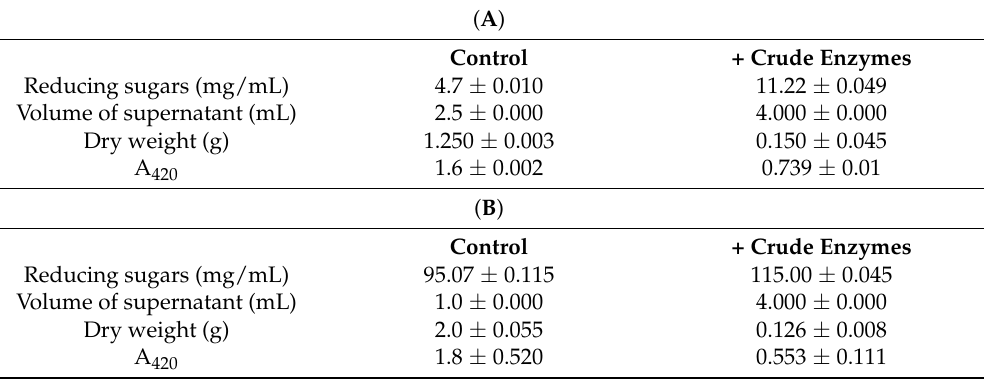
Table 8. ( A ) Effect of crude enzyme on the clarification rate of citrus juice. The reducing sugars, the volume and A 420 were measured in the supernatant and the dry weight in the pellet, after centrifugation of treated citrus juice; ( B ) Effect of crude enzyme on the clarification rate of apple juice. The reducing sugars, the volume and A 420 were measured in the supernatant and the dry weight in the pellet, after centrifugation of treated apple